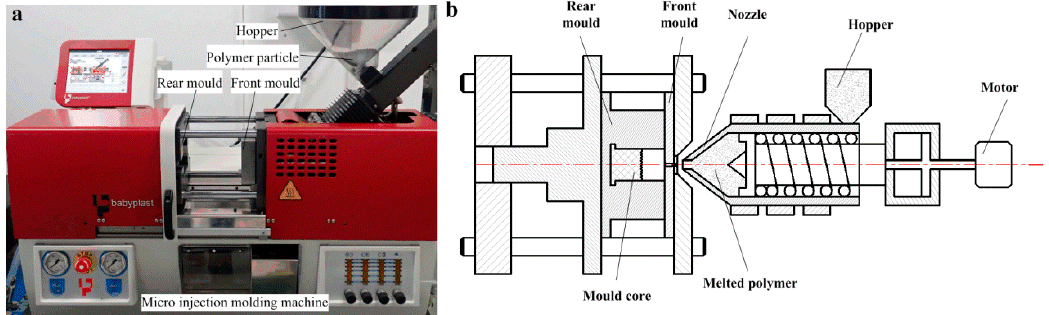
Figure 2. Photo and working principle of the micro injection molding machine: ( a ) photo; ( b ) working principle.